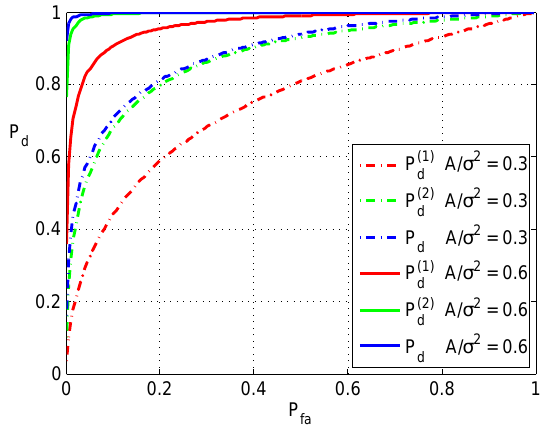
Figure 5. ROC curves of